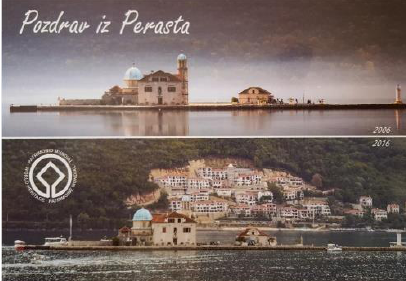
Figure 10. “Greetings from Perast”, an ironic postcard from the theatre play ‘Koto(r) o Kotoru” (Source: Kosara